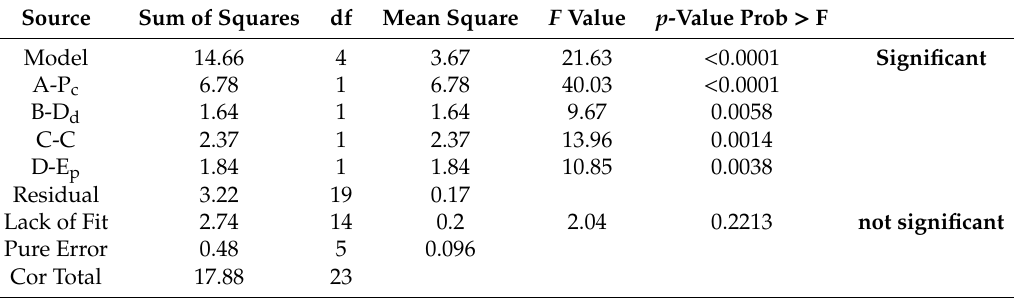
Table 4. ANOVA for linear model of the surface